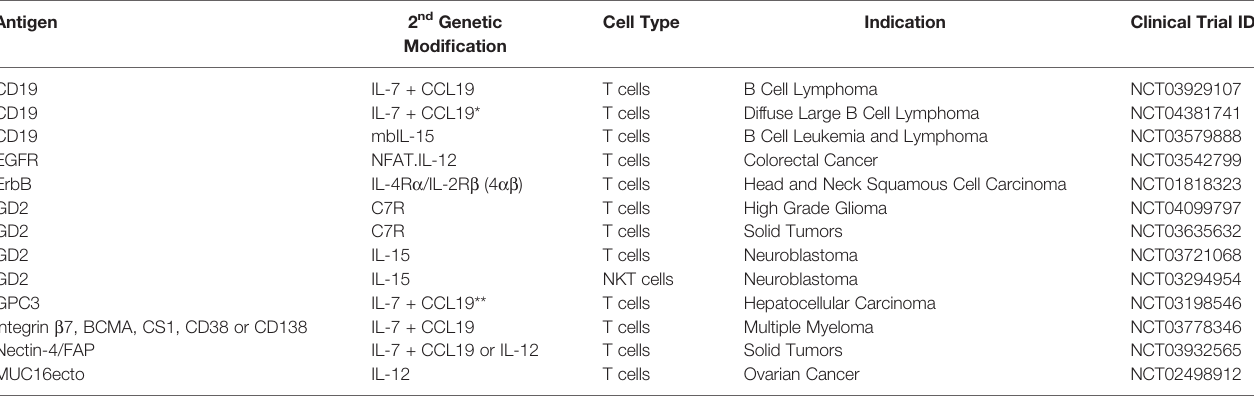
TABLE 1 | Selected CAR T cell clinical trials with additional modi fi cations to enhance signal 3. Antigen 2 nd